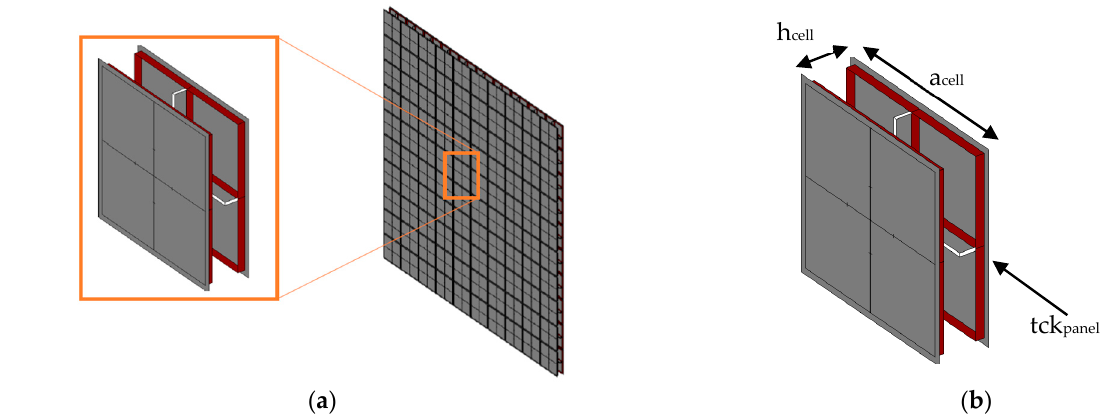
Figure 4. ( a ) Elementary cell detail extracted from periodic Metasolution and ( b ) characteristic dimensions. Table 1. Steel physical properties.